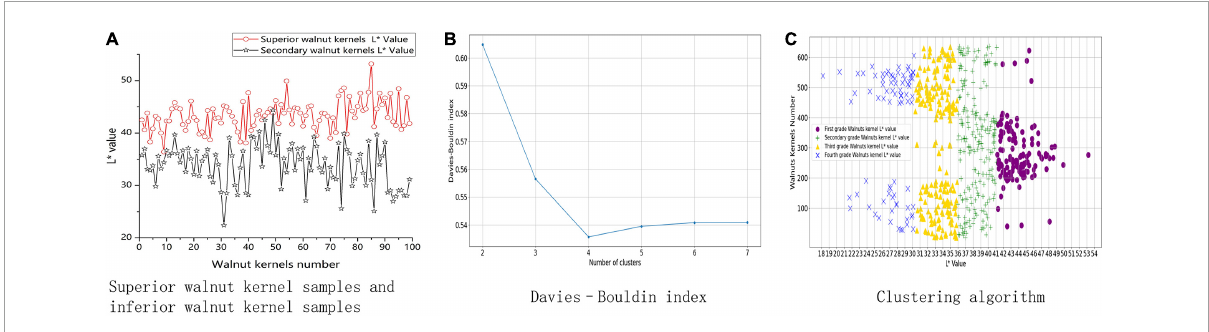
FIGURE3 Walnut kernel association model construction process. (A) Shows measurements of L* values for superior and inferior walnut kernels. (B) Shows the result of the Davies˝UBouldin index. (C) Shows the result of clustering algorithm.